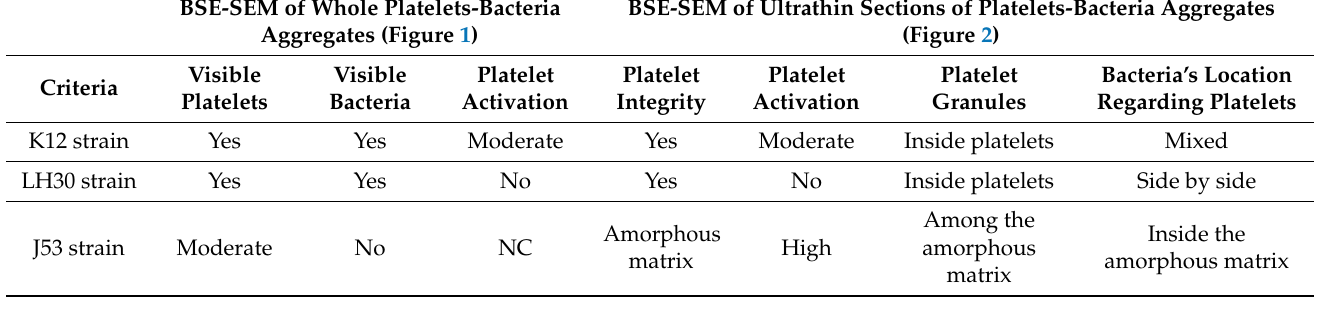
Table 2. Description of whole and sectioned platelets-bacteria aggregates using SEM.